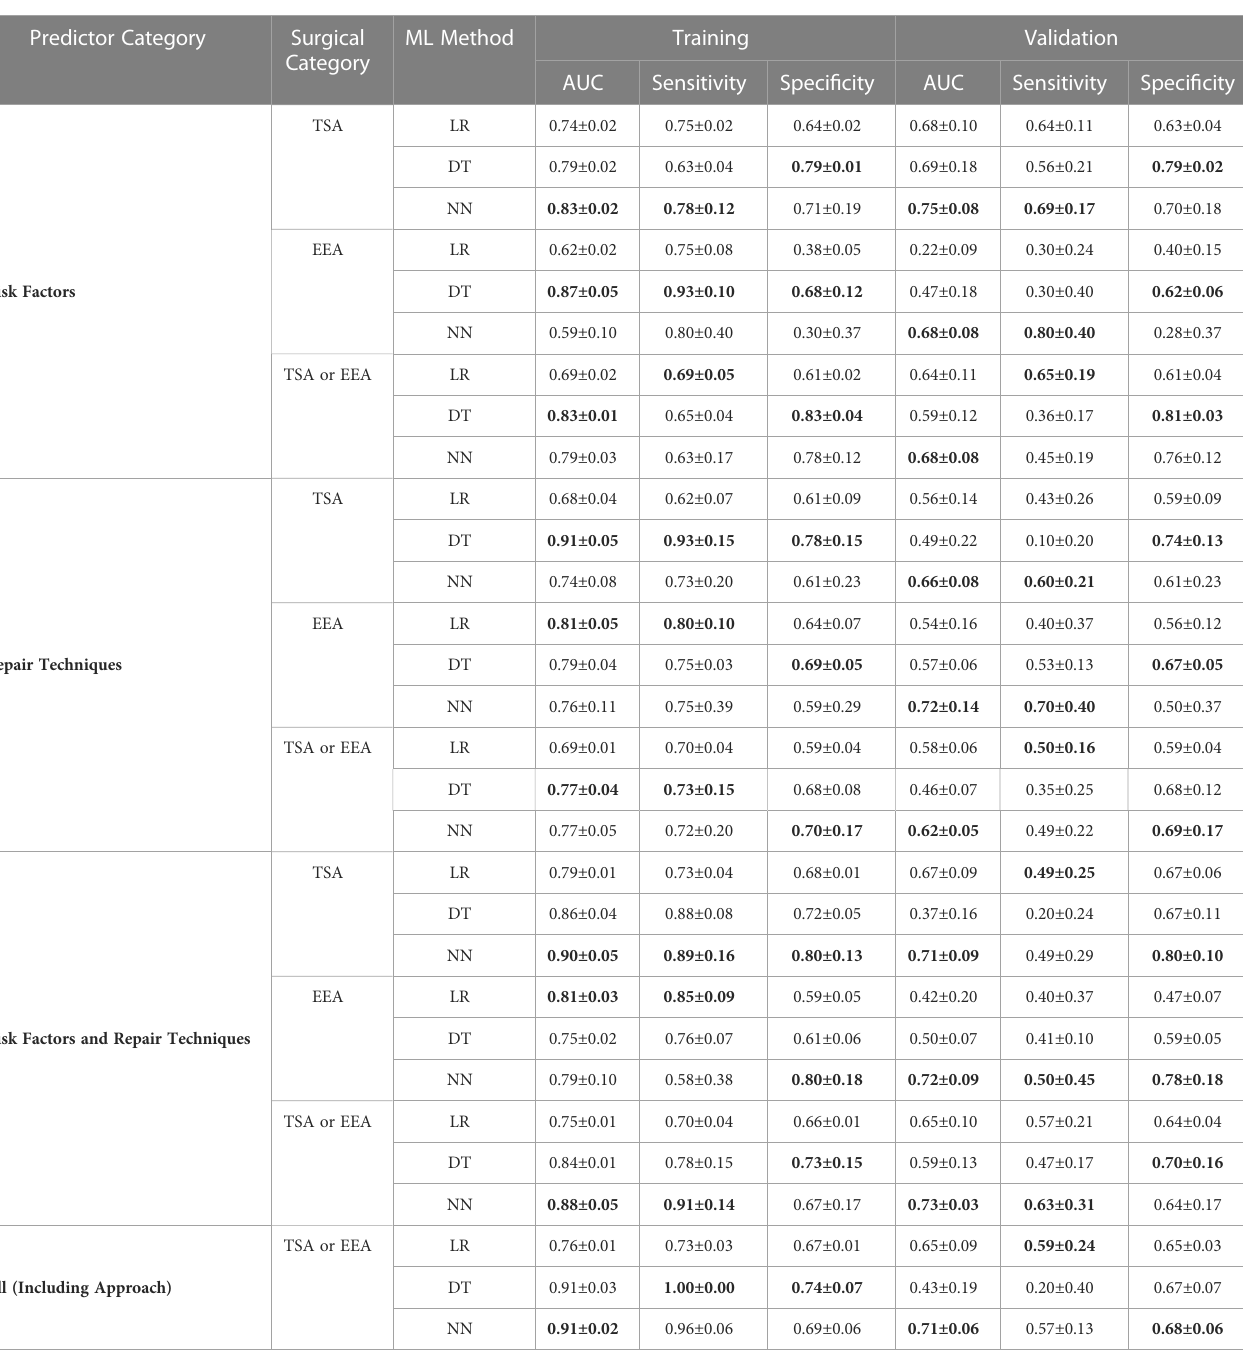
TABLE 2 Performance of